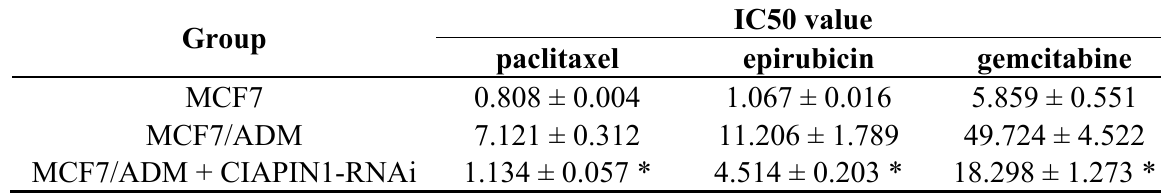
Table 2. IC50 values of MCF7/ADM cell line against various chemotheraputic drug before and after RNAi ( μ g/mL, x ± s